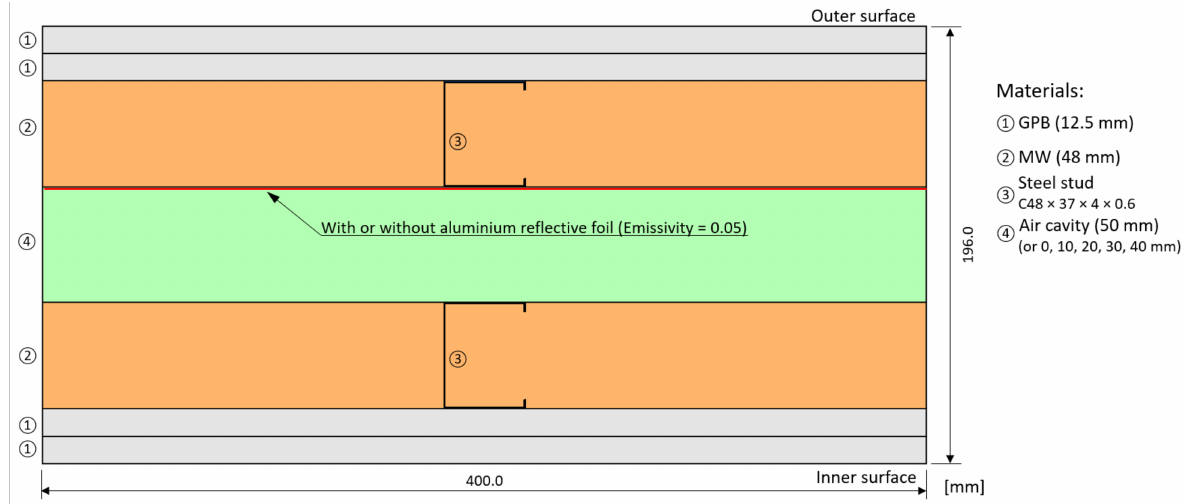
Figure 1. Ideal geometry and materials for a double pane LSF wall with different air cavity thicknesses, with and without a reflective aluminium